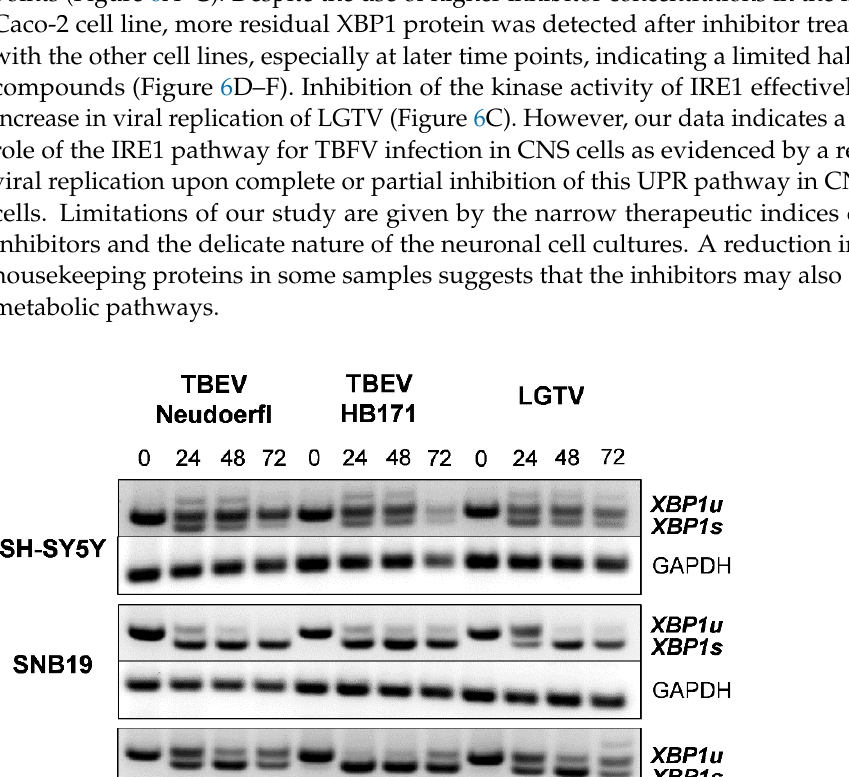
Figure 4. Infection experiments with the neuronal cell line SH-SY5Y were repeated as described in Figure 1, but cells were pretreated with IRE1 inhibitors KIRA6 (KIRA), STF083010 (STF) and GSK2850163 (GSK) for four hours prior to infection as well as after infection or left untreated. Viral RNA was extracted from culture supernatants and cell lysates were col- lected at 0, 24, 48 and 72 h post infection. Infections of untreated cells with Neudoerfl are shown in green ( A ), HB171 in blue ( B ) and LGTV in pink ( C ). Infections of cells pretreated with KIRA are shown in light brown, STF in light grey and GSK in dark grey, respectively. All infections were performed in triplicates and repeated three times. Statistical analyses were performed by 2-way ANOVA with Tukey’s multiple comparison test, ** p < 0.002, *** p < 0.001. Cell lysates were analyzed by Western blot for XBP1 expression after infection with Neudoerfl ( D ), HB171 ( E ) or LGTV ( F ). GAPDH expres- sion was analyzed as a housekeeping control. A representative blot is shown. kDa, kilodalton.